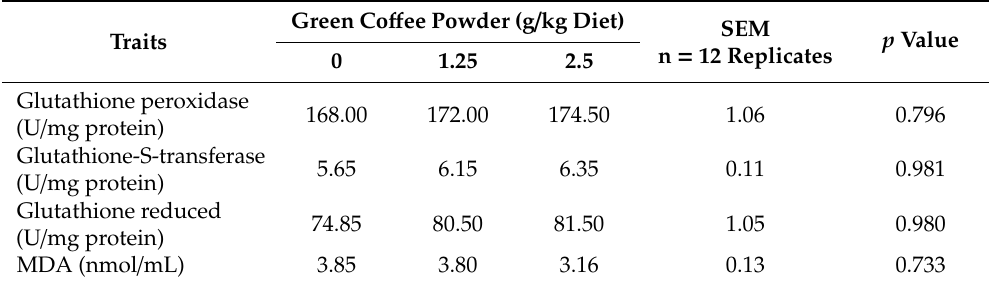
Table 5. The fluctuations in lipid peroxidation (MDA), glutathione peroxidase, glutathione-S-transferase, and glutathione levels reduced in broiler chicks administrated to levels of green co ff ee powder were not significantly a ff ected against the control. Table 5. The e ff ect of green co ff ee supplementation of serum oxidative stress markers of broiler chicks at two levels (1.25 and 2.5) compared to